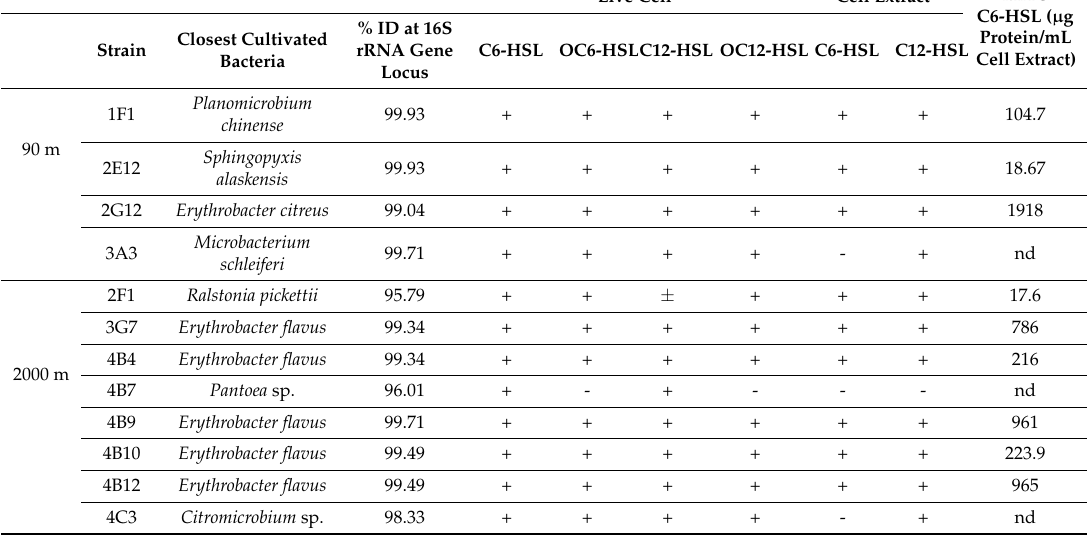
Table 1. Identification and characterization of the marine isolates showing wide Quorum-Quenching (QQ) activity. The presence of QQ activity in the cell extracts and the minimal active concentration of extract (MAC, µ g protein/mL cell extract) needed to fully eliminate the activity of 10 µ M of C6-HSL was also